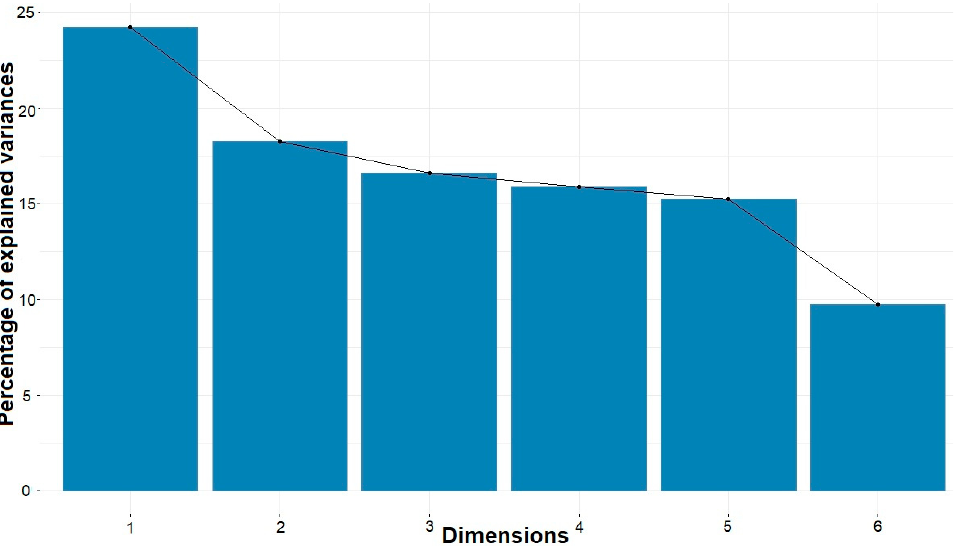
Figure 4. Scree plot from Principal Component Analysis (PCA).